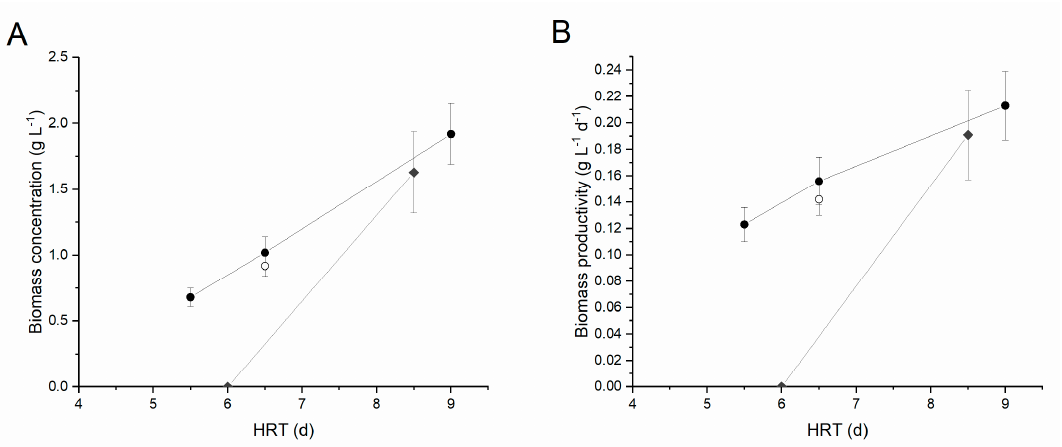
Figure 3. Biomass concentration ( A ) and productivity ( B ) at steady state as a function of the hydraulic retention time. Black circles indicate centrifuged digestate diluted 1:5, grey diamonds centrifuged digestate (CD) diluted 1:2, while open circle corresponds to FD diluted 1:5. Error bars represent standard deviation.